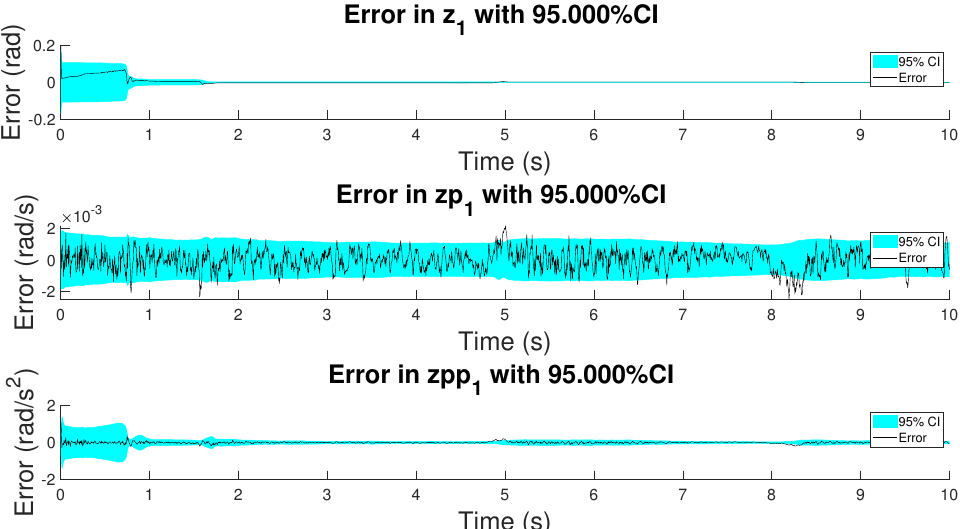
Figure 10. Error and confidence interval of the position, velocity and acceleration of the crank angle in the configuration which considers a gyroscope on the coupler.